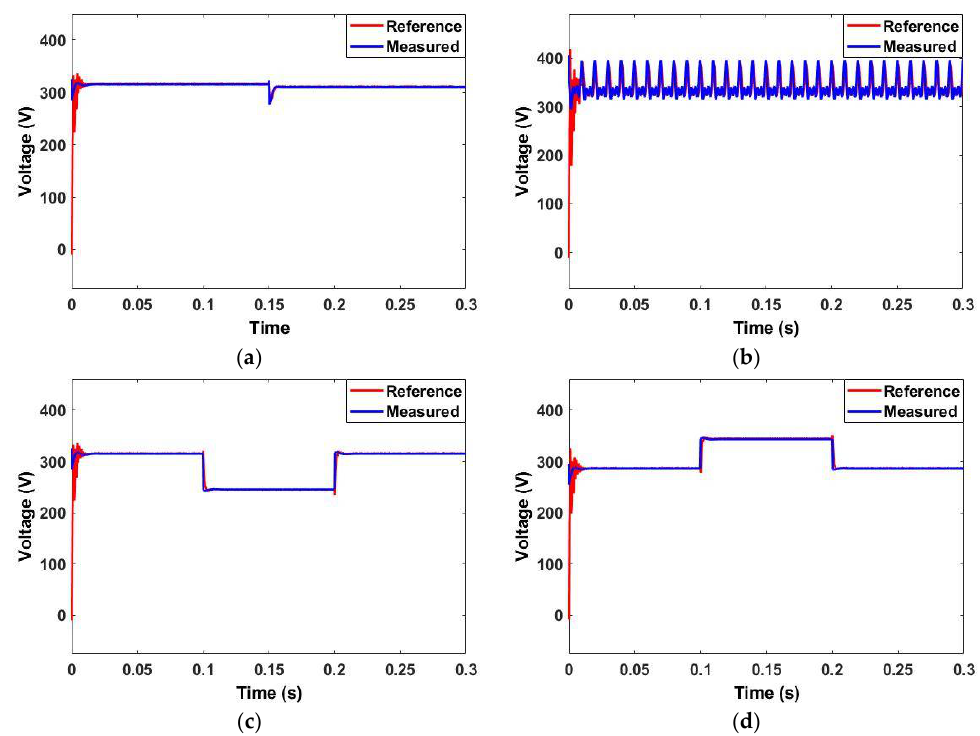
Figure 8. DC link voltage V dc using SMC controller: ( a ) under NGO with a step response of 0.15 s; ( b ) under AGO; ( c ) during voltage sag and ( d ) voltage swell in grid voltage.